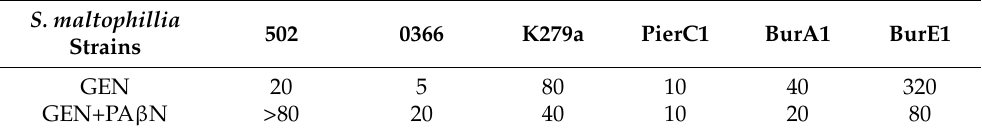
Table 3. MICs ( µ g/mL) of gentamicin (GEN) (the concentrations range from 2.5 to 320 µ g/mL) in the absence and presence of an efflux pump inhibitor (EPI), phenylalanine-arginine β -naphthylamide (PA β N), at concentration of 25 µ g/mL. The test was performed on six S. maltophillia strains.